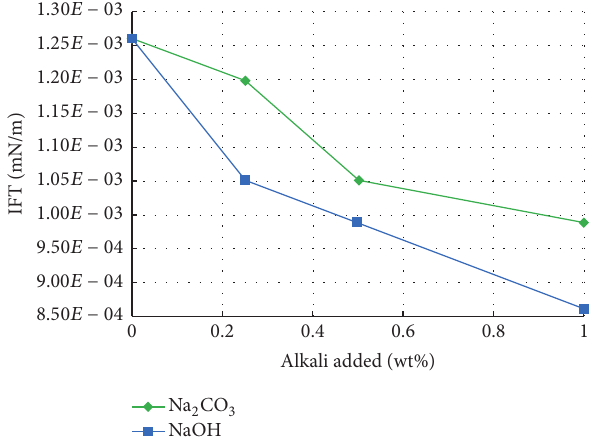
Figure 5: IFT versus alkali weight fraction and type